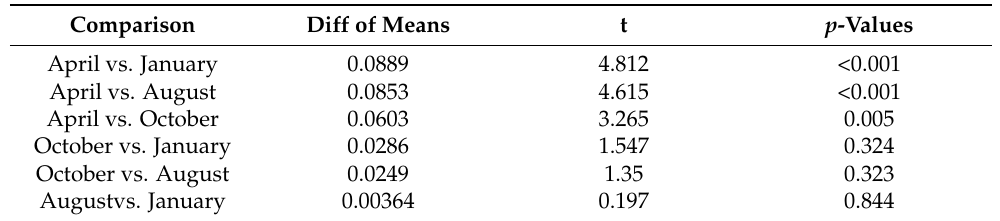
Table 5. Statistics of NDVI values for the High Atlas Mountains of Morocco in four periods of 2020. The NDVI was calculated from Landsat 8 data. To separate means a pairwise multiple comparison procedure (Holm–Sidak Method) was used (n = 239).